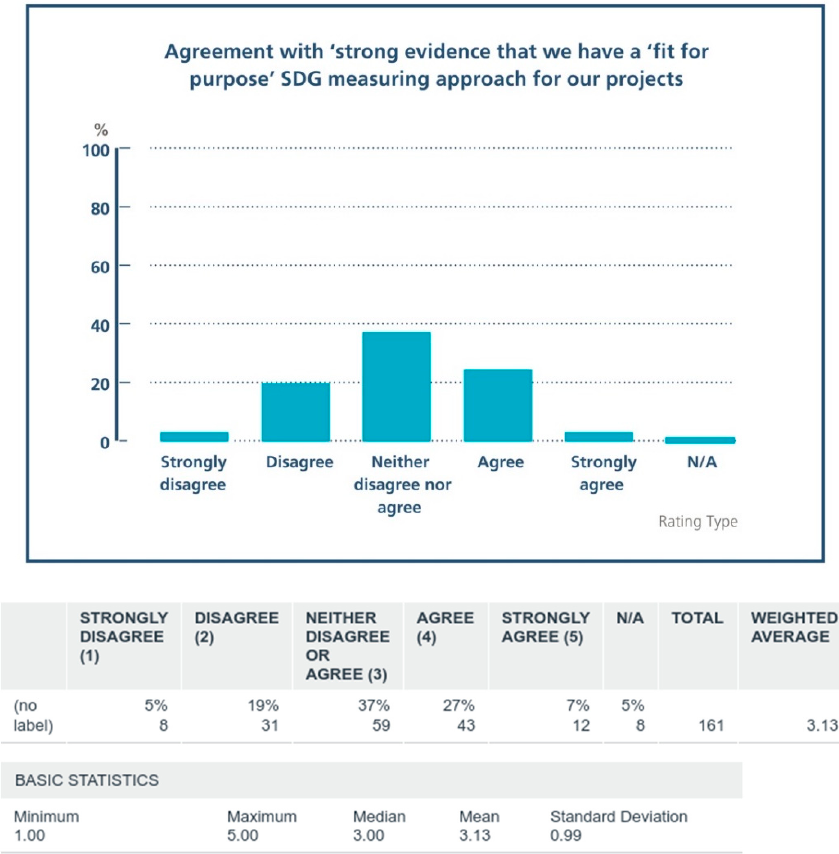
Figure 12. Response to Question 5: Do we have a ‘fit for purpose’ measuring approach to track projects’ SDG impact?